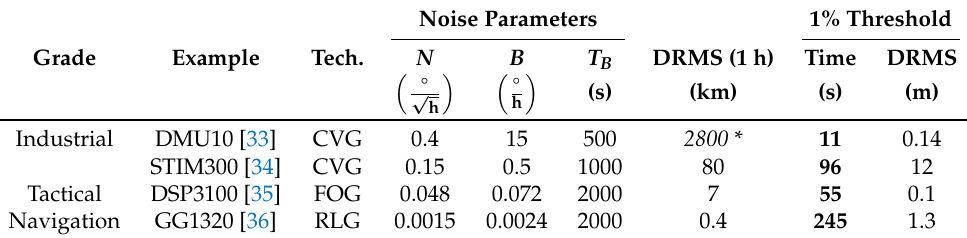
Table 2. Maximum mission time that allows for the neglect of the gyro bias instability for different sensor grades. Below the threshold time, the bias instability’s contribution to the total position error is less than 1% of the angular random walk’s